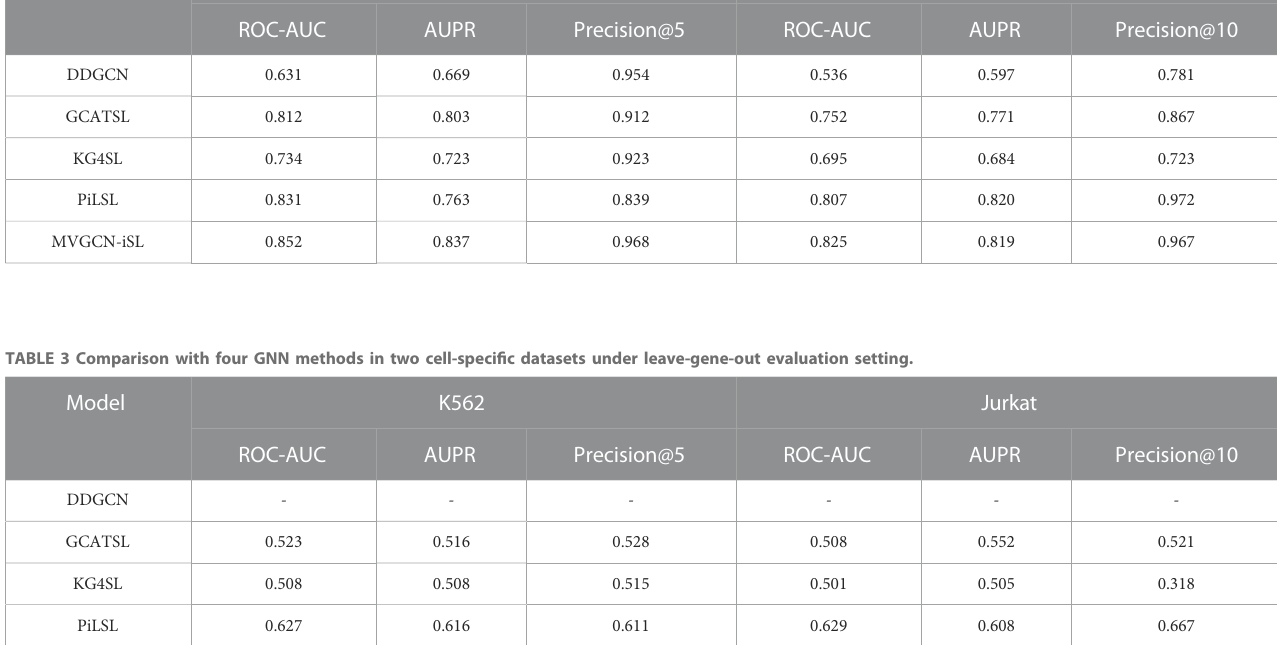
TABLE 2 Comparison with four GNN methods in two cell-speci fi c datasets under leave-gene-combination-out evaluation setting. Model